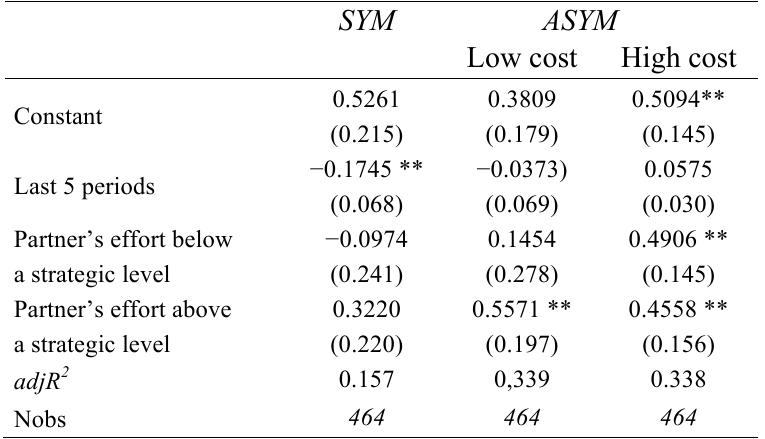
Table 5. Choice of team remuneration in VOLUNTARY SYM and ASYM